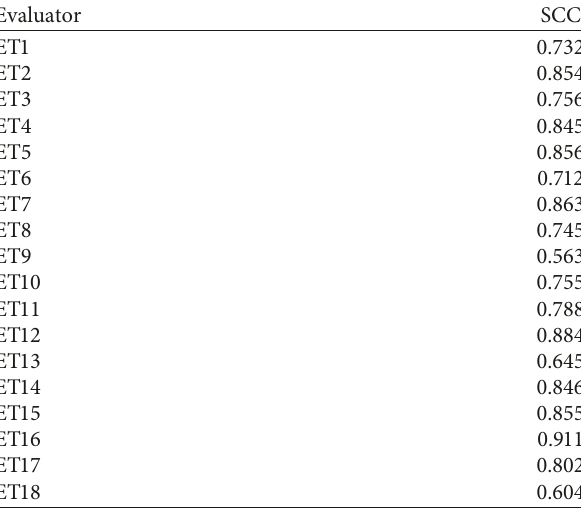
Table 1: Spearman correlation coefficient (SCC).